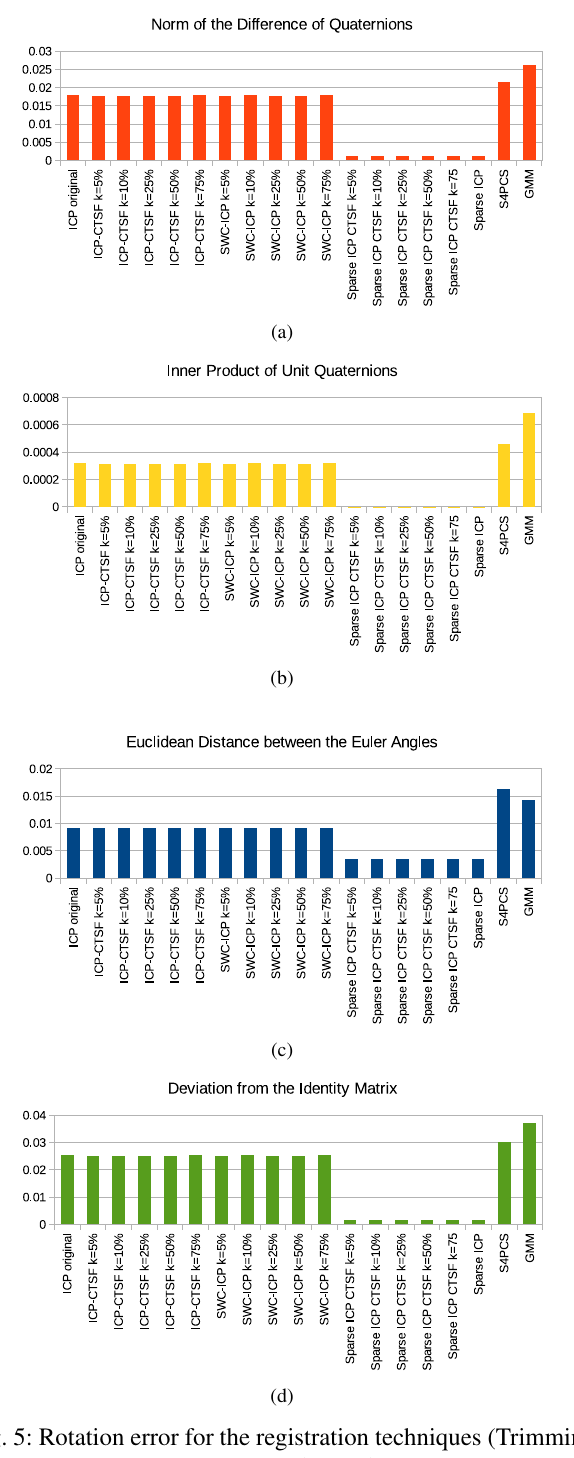
45 ◦ , computed using: (a) −